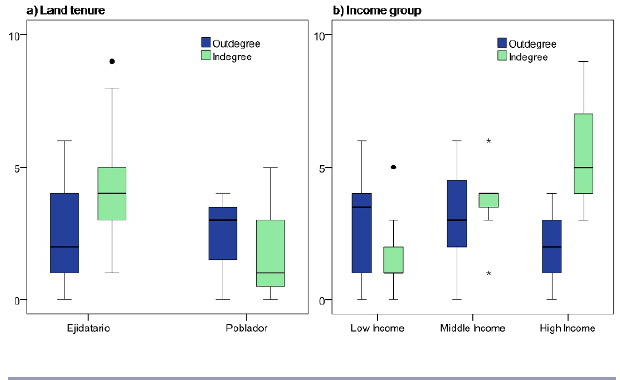
Fig. 2 . Outdegree and indegree boxplots for (a) land tenure (ejidatario versus poblador) and (b) income group (terciles of